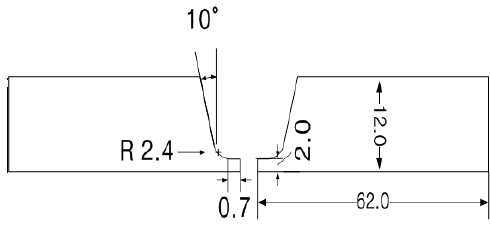
Figure 1. Specimen with U-groove (Unit: mm).